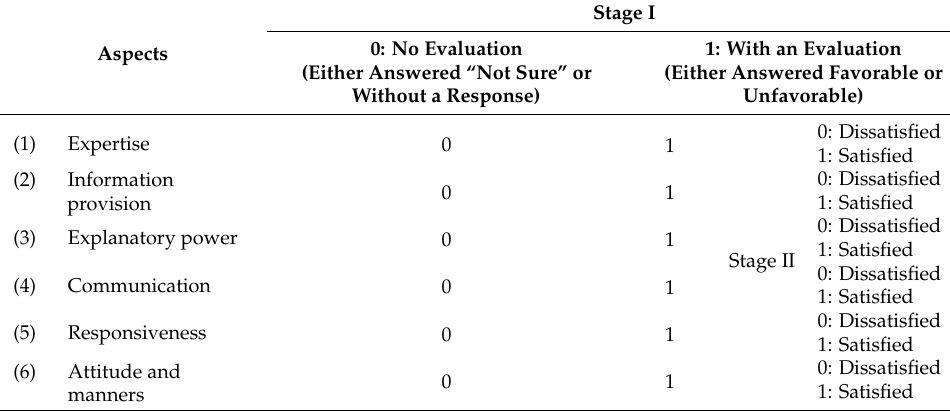
Table 2. The two-stage setting of the evaluation of satisfaction with